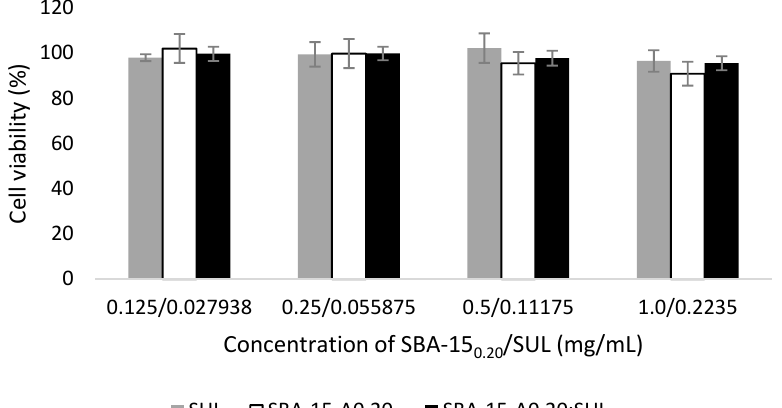
Figure 8. Caco-2 cell viability results after 2 h incubation with SBA-15-A 0.20 , SBA-15-A 0.20 :SUL, and Figure 8. Caco ‐ 2 cell viability results after 2 h incubation with SBA ‐ 15 ‐ A 0.20 , SBA ‐ 15 ‐ A 0.20 :SUL, and SUL at 37 ◦ SUL at 37 °C.